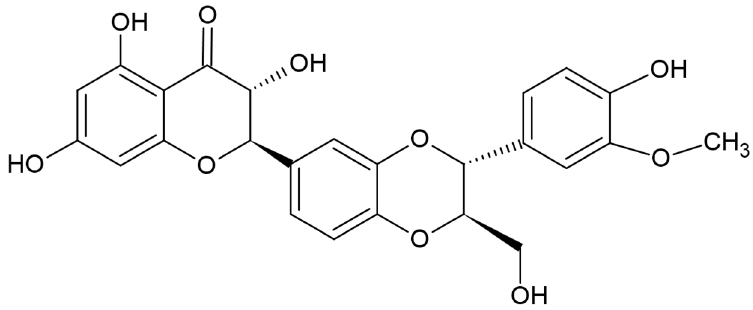
Figure 1. Chemical structure of silibinin.